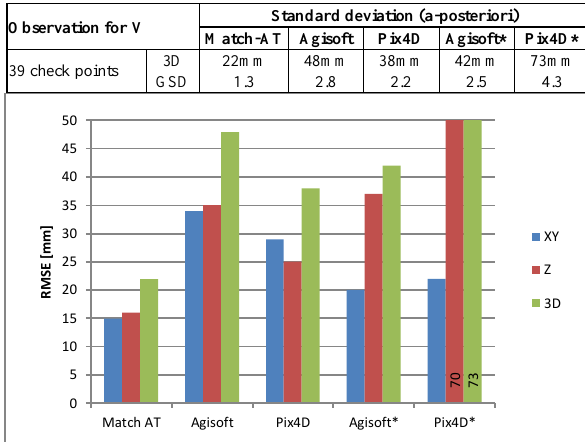
Figure 16: RMSE results at 39 check points (configuration V)